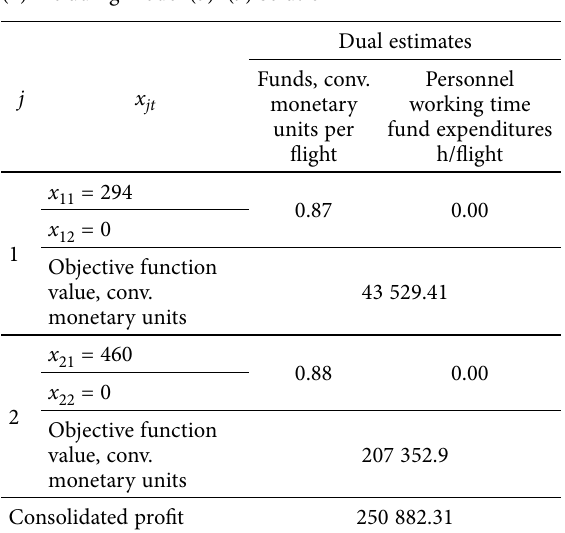
Table 6. The results of model experimental computations (1)– (4) including model (5)–(9) solution